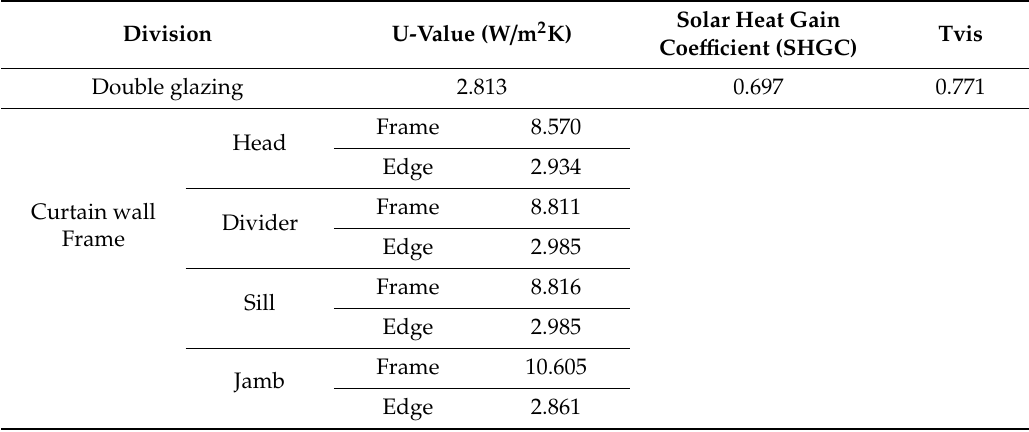
Table 2. Analysis results for optical and thermal properties of the glazing and frame of existing old curtain walls.